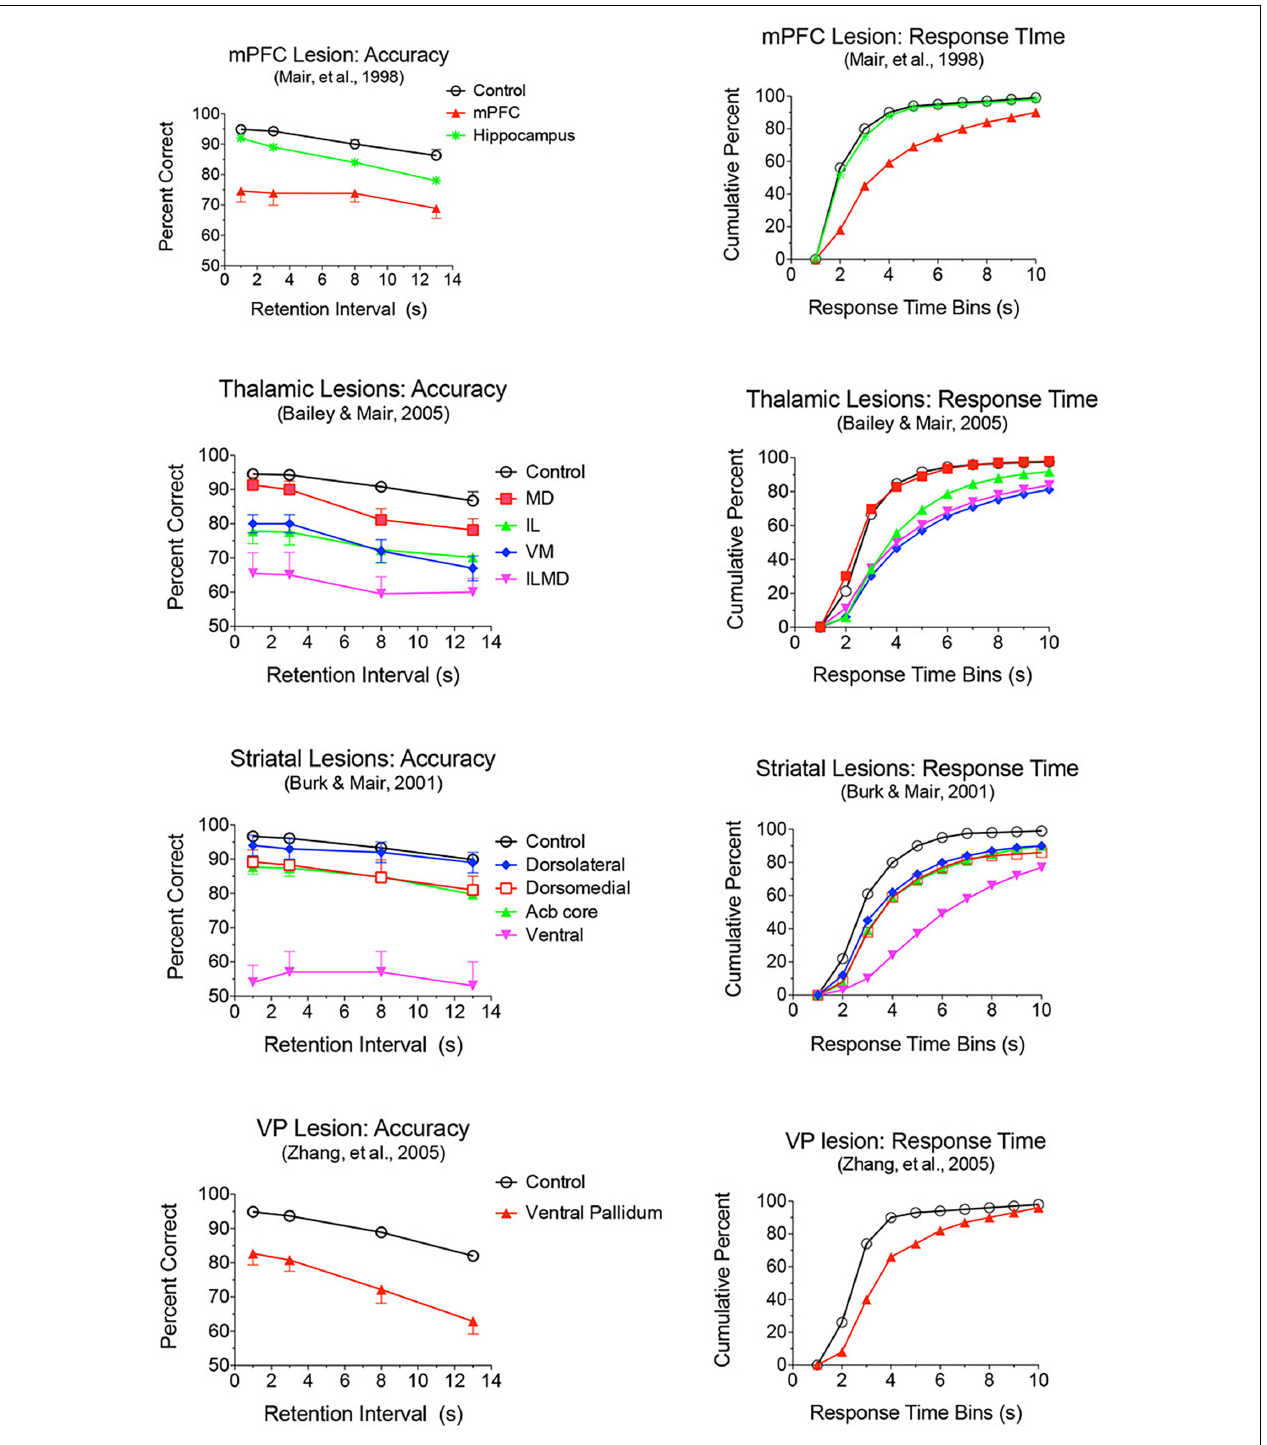
FIGURE 6 | Effects of mPFC, hippocampus, thalamic, striatal, and ventral pallidal lesions on DMTP trained in operant chambers with 3 retractable levers: two on the front wall for sample and choice responses and one on the back wall to initiate trials and to force rats to disengage from front wall levers during memory delays. Accuracy is plotted as percent correct as a function of memory delay and response time (RT) as cumulative functions showing the percentage of choice responses made in 1 s bins after the end of the memory delay. Hippocampal and mediodorsal thalamic (MD) lesions produced delay-dependent impairment of accuracy and had no effect on RT. Dorsolateral lesions had no significant effect on accuracy or RT. Dorsomedial and nucleus accumbens (Acb) core produced delay independent deficits in accuracy, significantly and had no significant effect on RT. mPFC, ventral pallidum, ventral striatum, and Intralaminar (IL), ventromedial (VM), and combined intralaminar/mediodorsal (ILMD) thalamic lesions produced delay-independent deficits in accuracy and increased median RT significantly.